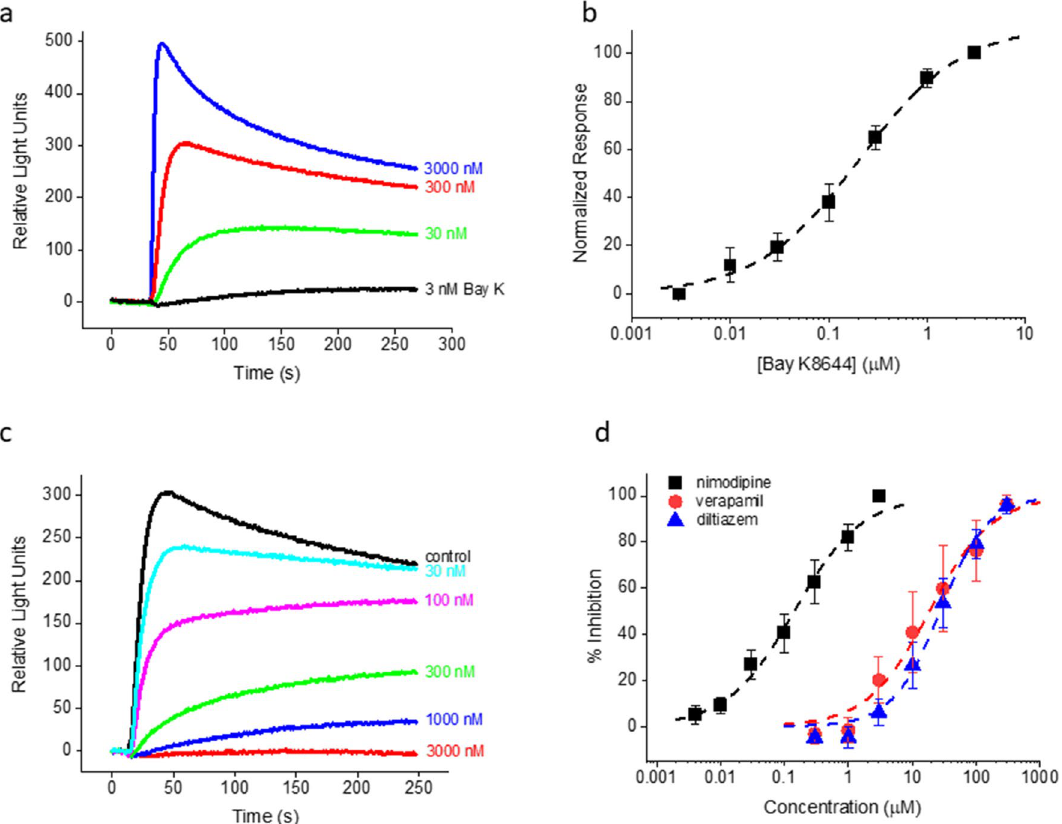
Figure 3. LTCC pharmacology from rat cortical cultures. ( a ) Fluorescent responses to a range of Bay K8644 concentrations. ( b ) Summary of Bay K concentration dependence for seven independent experiments similar to ( a ). EC 50 = 203.9 nM from the best fit (dashed curve) to the data. ( c ) Fluorescent responses to Bay K8644 for a range of nimodipine concentrations. ( d ) Summary of concentration dependence data for multiple experiments for nimodipine, verapamil and diltiazem. The EC 50 values from the best fits (dashed curves) to the nimodipine (n = 12), verapamil (n = 4) and diltiazem (n = 6) data were 142.4 nM, 18.5 µM and 27.1 µM, respectively. The concentration of Bay K8644 was 300 nM in ( c ) and ( d ). The holding [K + ] was 20 mM in all the